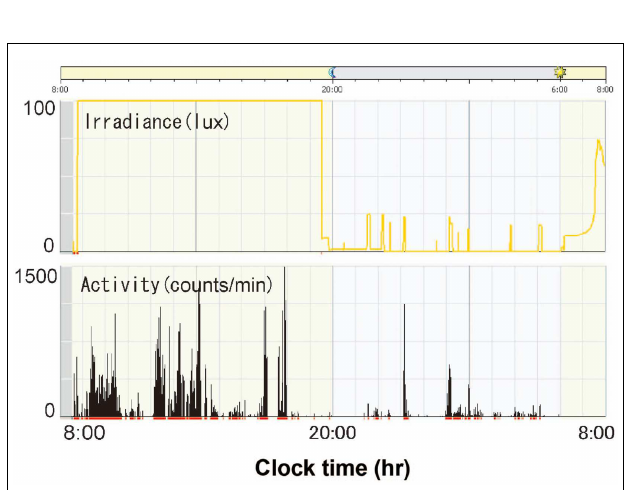
FIGURE 9 | Illumination inside incubators and actograms of rest-activity in representative infants who were with/without filters at 35weeks gestational age . Dark bars represent activity.The time of day is shown at the top. Note that circadian patterns of rest and activity are more apparent in infants with a filter at nights (B) than in infants with no filter (A) .